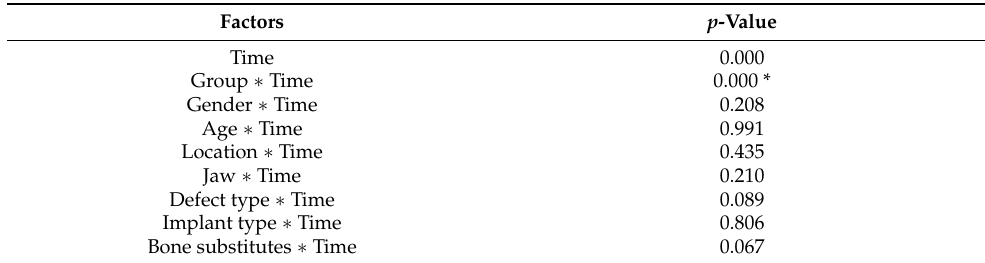
Table 4. Results of generalized linear mixed effect model regarding the primary outcome (labial thickness of the hard tissue at the implant